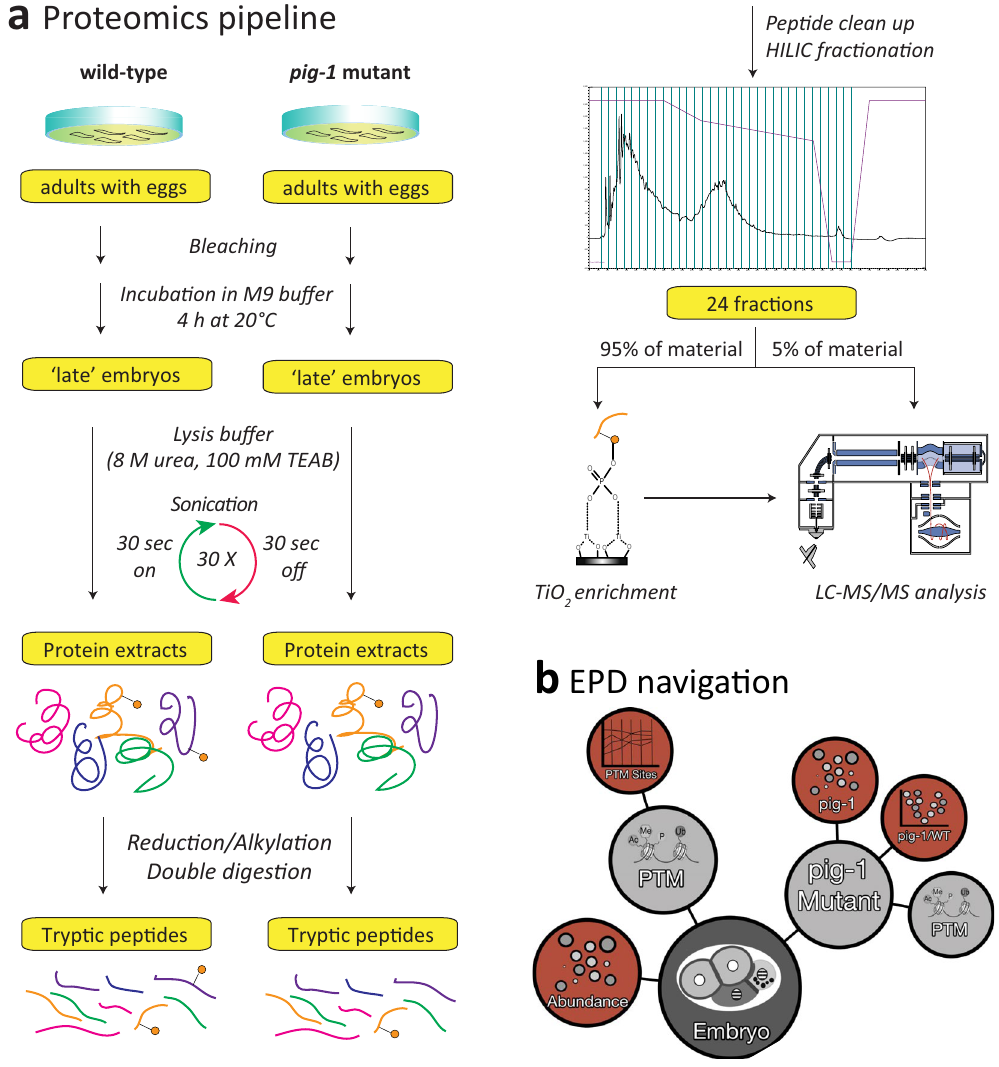
Figure 3. Mass spectrometry-based proteomics analysis and data deposition at the Encyclopedia of Proteome Dynamics (EPD). ( a ) Proteomics pipeline with a phosphopeptide enrichment step using titanium dioxide (TiO 2 ) (for experimental details please refer to Materials and Methods). 95% of each peptide fraction was used to enrich for phosphopeptides using TiO 2 affinity chromatography 43 before being analysed by LC-MS/ MS. In addition, 5% of the peptide fractions were directly measured with LC-MS/MS to assess global protein abundances. HILIC = hydrophilic interaction chromatography, TiO 2 = titanium dioxide, LC-MS/MS = liquid chromatography tandem mass spectrometry. ( b ) Overview of protein abundance and post-translational modification (PTM) data from wild-type and pig - 1 mutant embryos available in the Encyclopedia of Proteome Dynamics